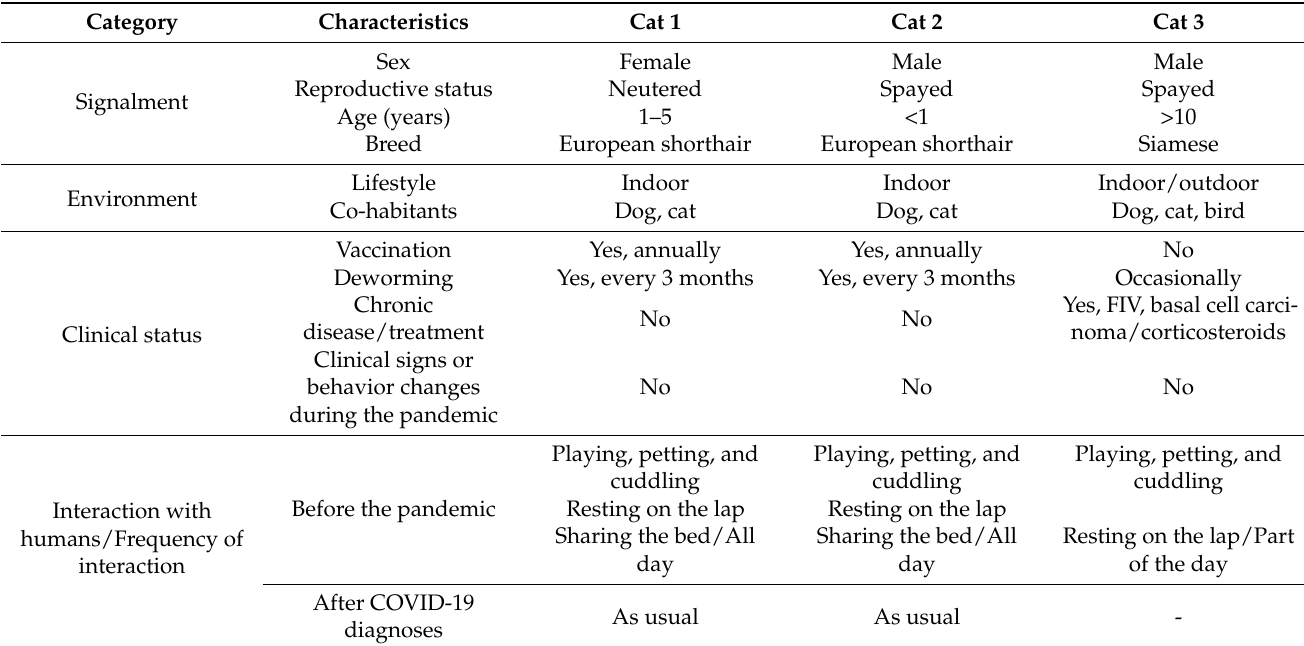
Table 3. Characterization of SARS-CoV-2-seropositive